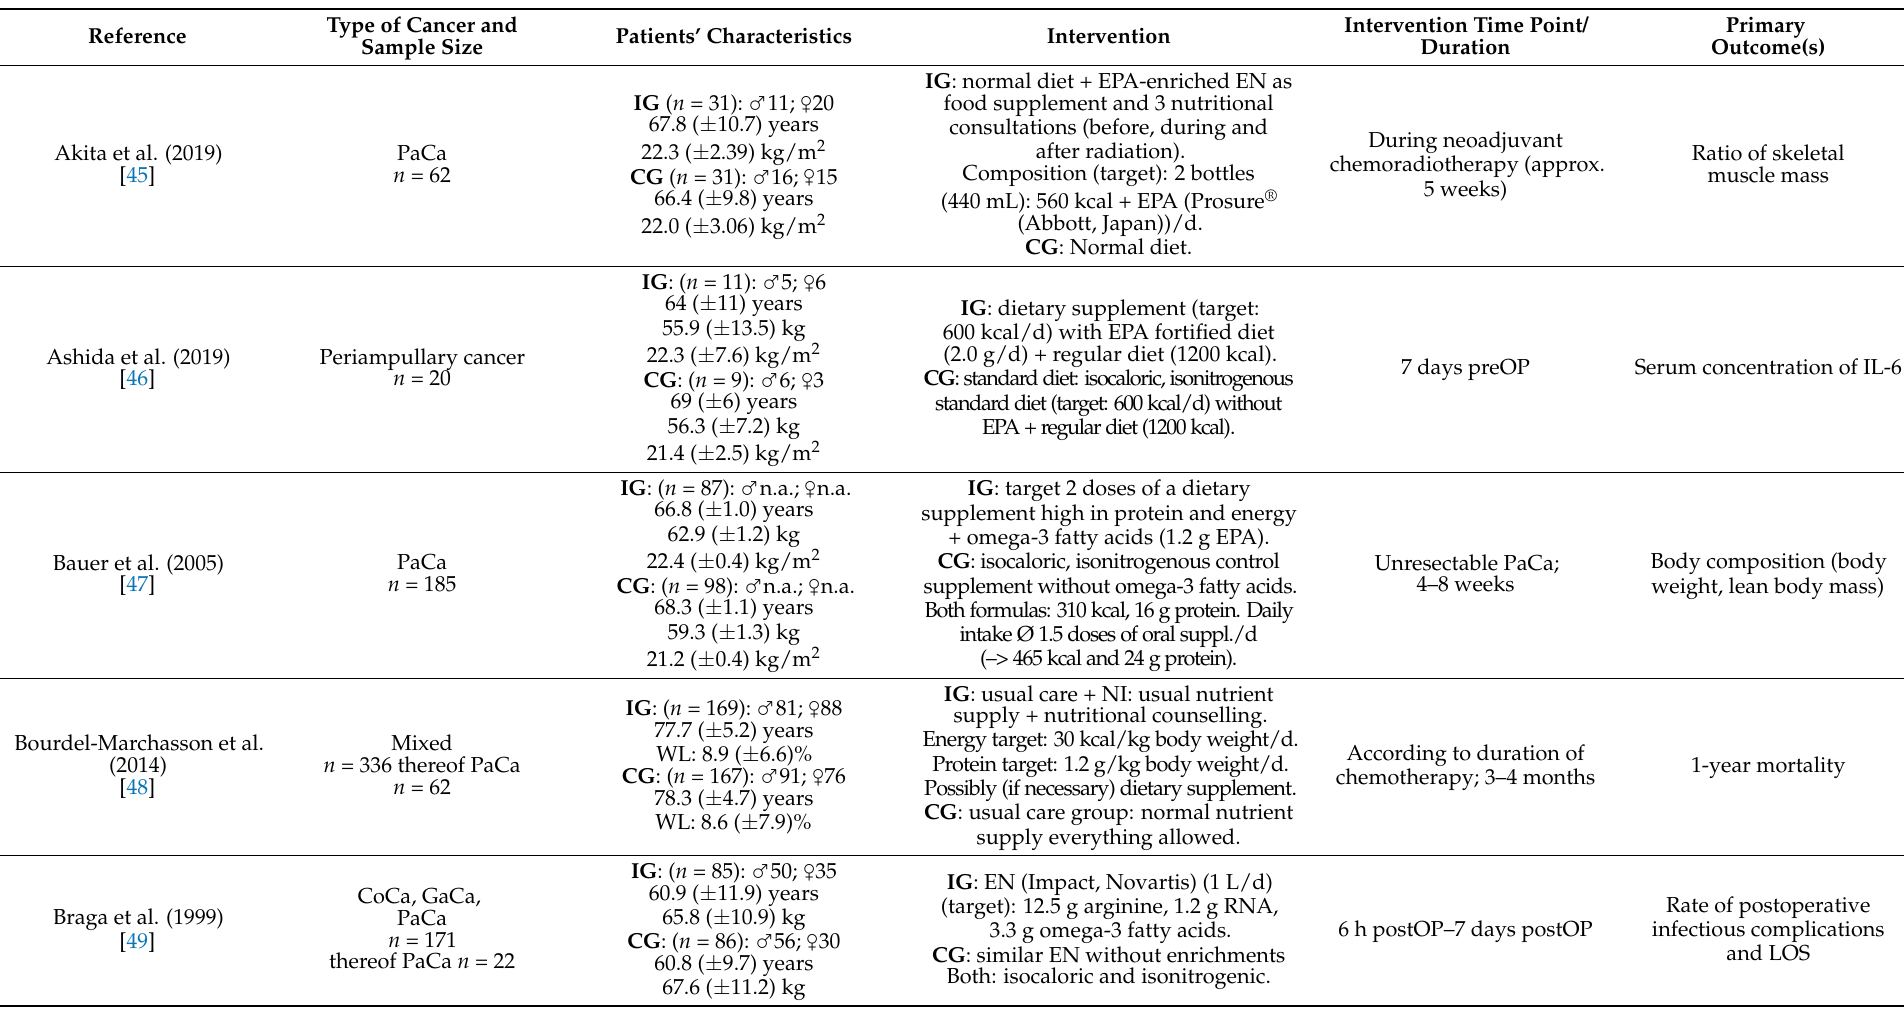
Table 1. Characteristics of included